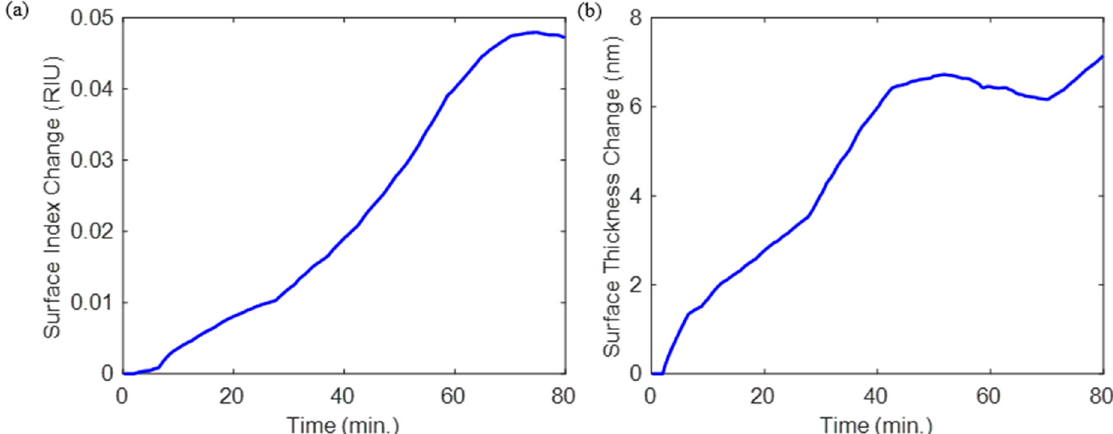
Figure 9. Changes in the ( a ) biolayer index of refraction and ( b ) biolayer thickness during the incubation of the sensor in Con A. During this process, the change in the bulk refractive index ( ∆ n bulk ) is calculated to be 0 RIU.